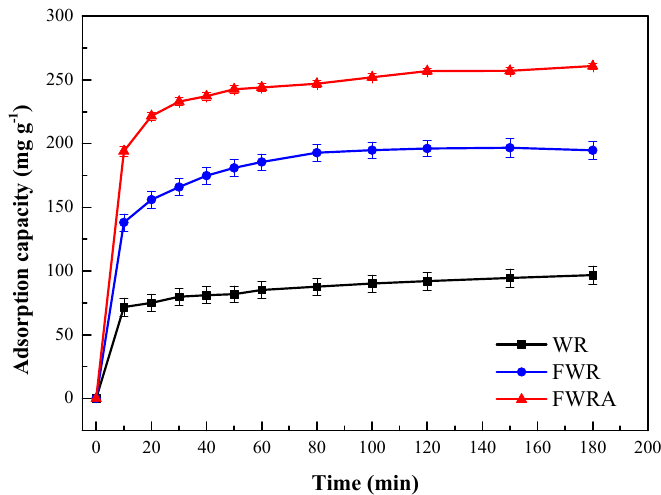
Figure 5. Adsorption performance of WR, FWR and FWRA. (MO of 50 mg/L, adsorbent of 12.5 mg (0.25 g/L), and 25 °C).